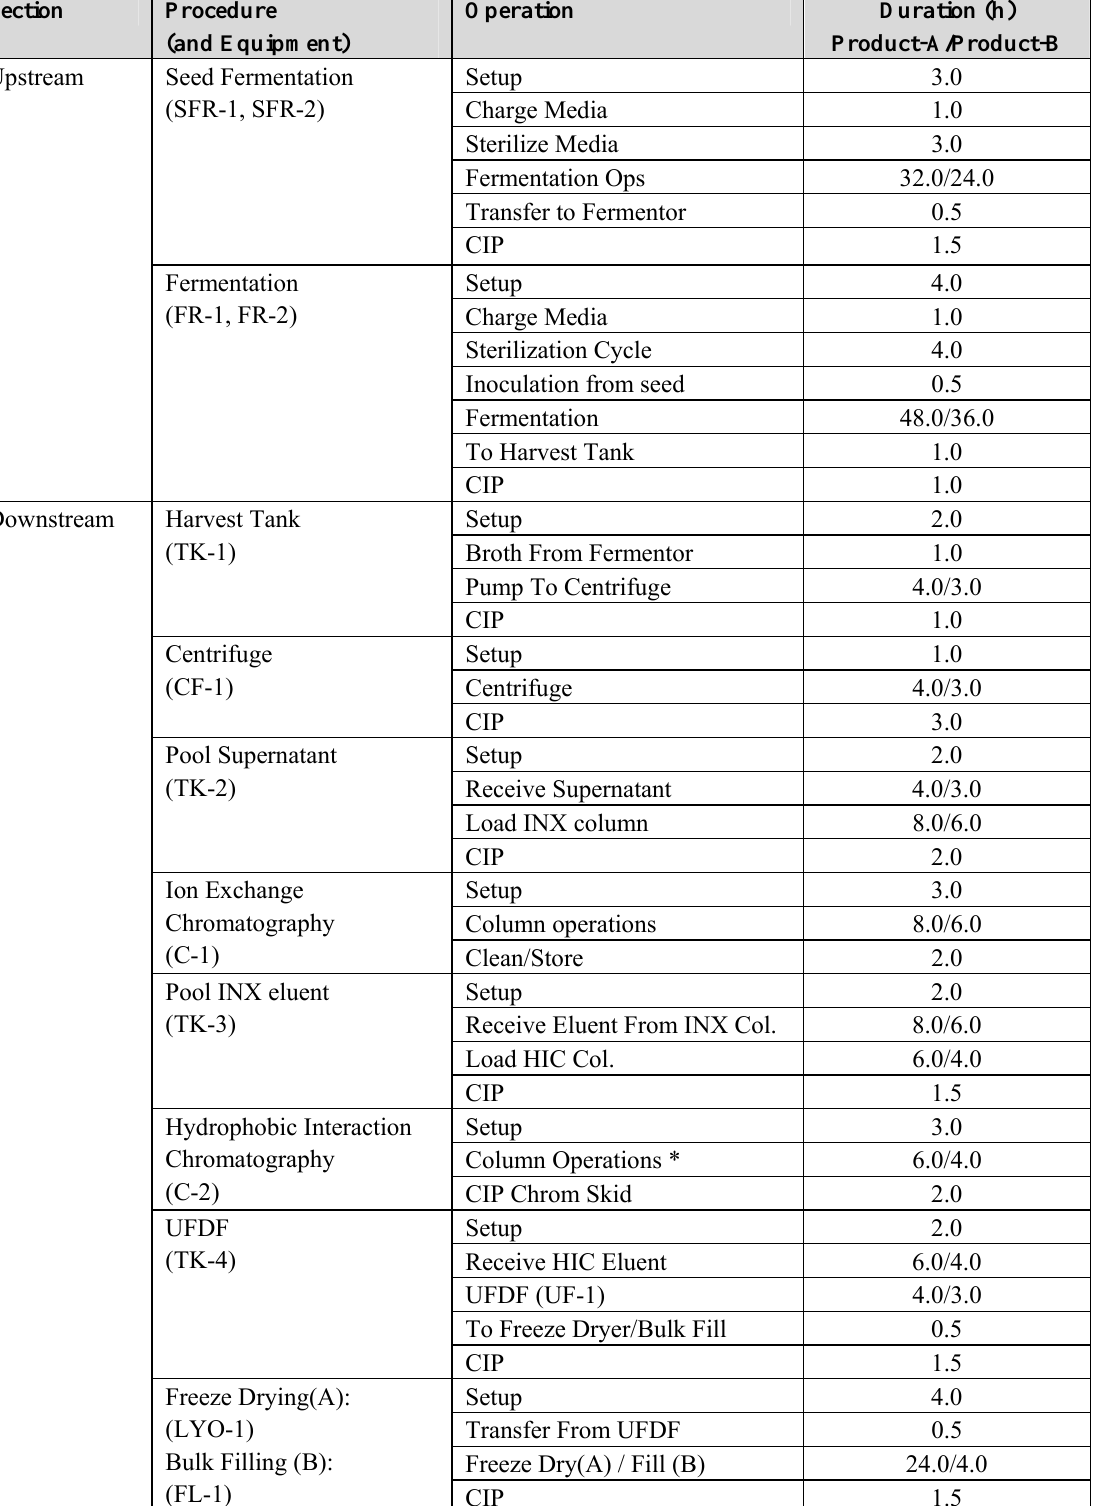
Table 7. Operational data for Product-A and Product-B